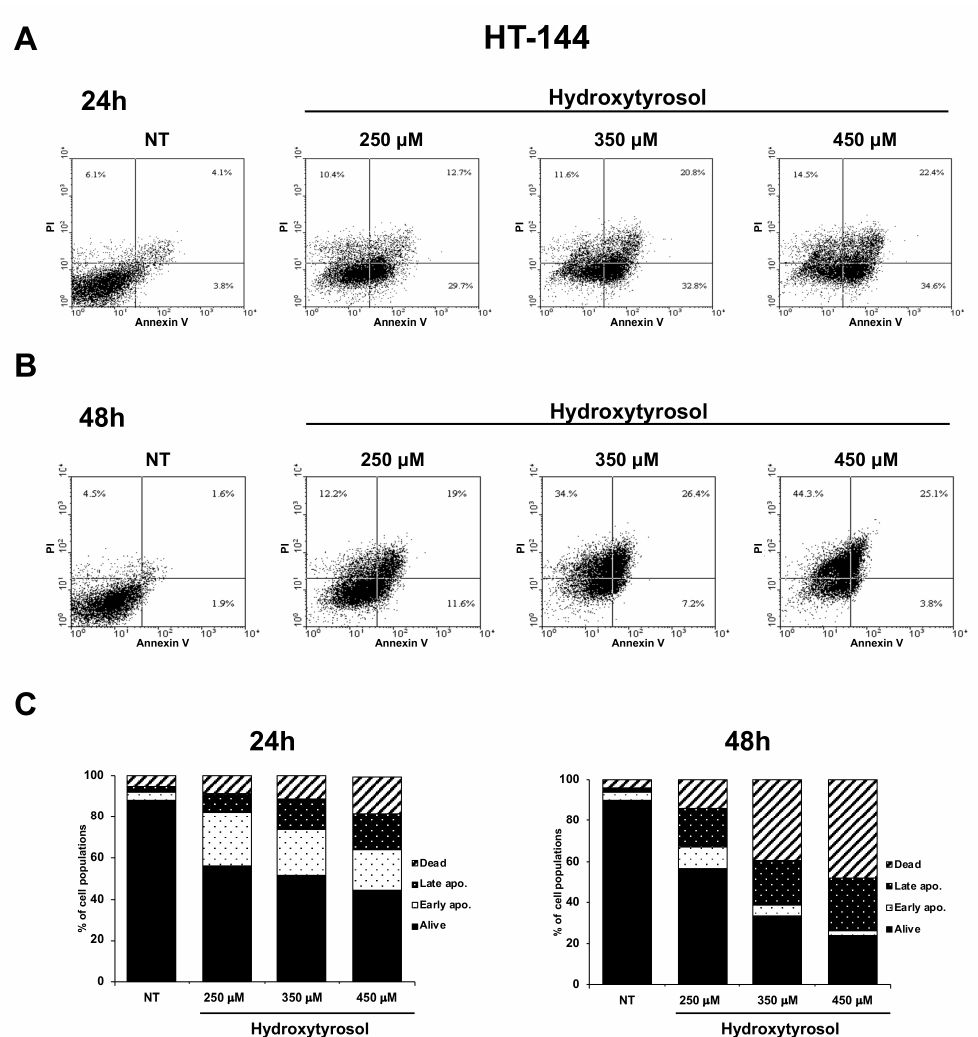
Figure 4. Flow cytometric analysis of HT-144 melanoma cells treated with hydroxytyrosol. HT-144 cells untreated (NT) or treated for 24 h ( A ) and 48 h ( B ) with 250 µ M, 350 µ M, and 450 µ M of hydroxytyrosol were analysed by annexin V-FITC / PI staining, through flow cytometry. The percentage of cells alive (lower left quadrant), early apoptotic cells (lower right quadrant), late apoptotic cells (upper right quadrant), and necrotic cells (upper left quadrant) were reported in flow cytometric graphics. The data reported are representative of several independent experiments of flow cytometric analysis. The percentage of early apoptotic, late apoptotic, and necrotic HT-144 cells untreated (NT) or treated for 24 h (left graphic) and 48 h (right graphic) with hydroxytyrosol as mean values of several di ff erent experiments are reported in the histograms ( C